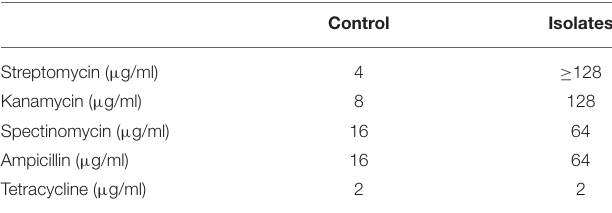
TABLE 2 | MIC values of streptomycin selected pGroEL/GroES isolates.